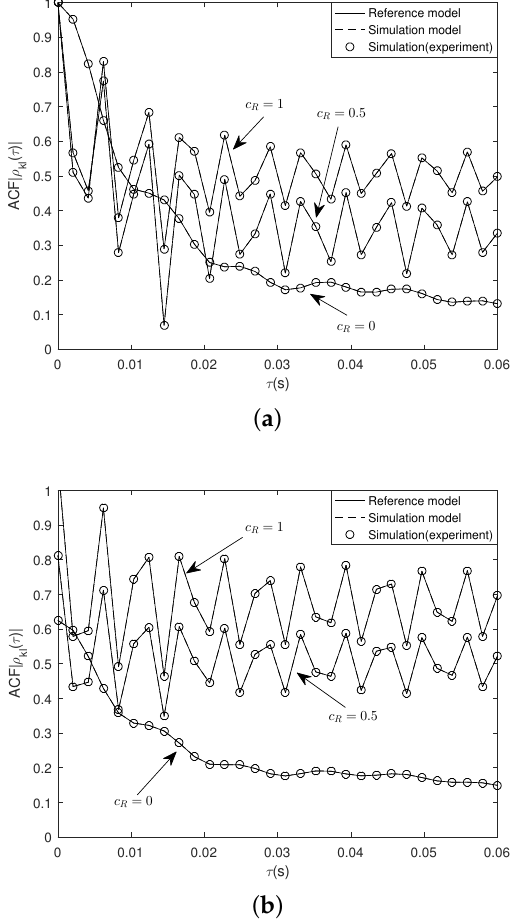
Figure 13. ACF of SRT and without ceiling for NLoS scenario ( c R = 1 ) . ( a ) SCCF of SRT. ( b ) SCCF of SRT without